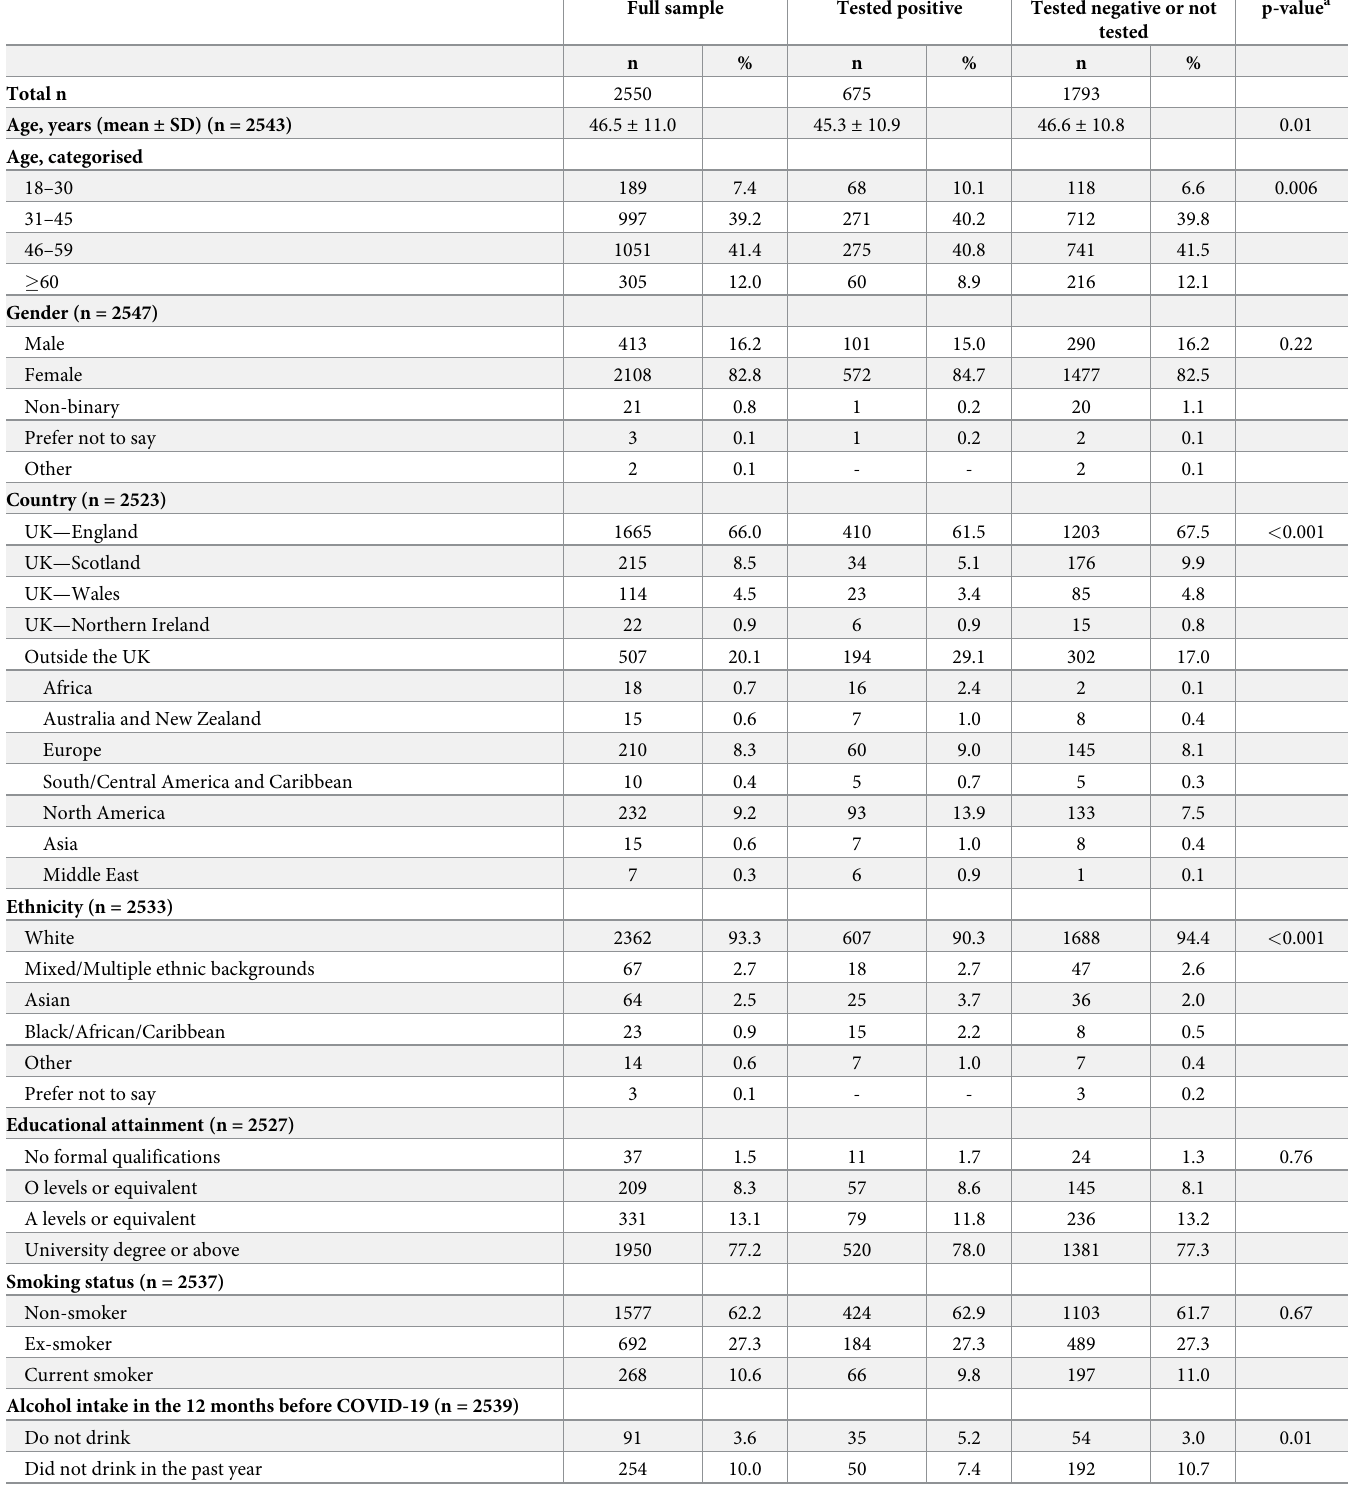
Table 1. Demographics and baseline health of survey